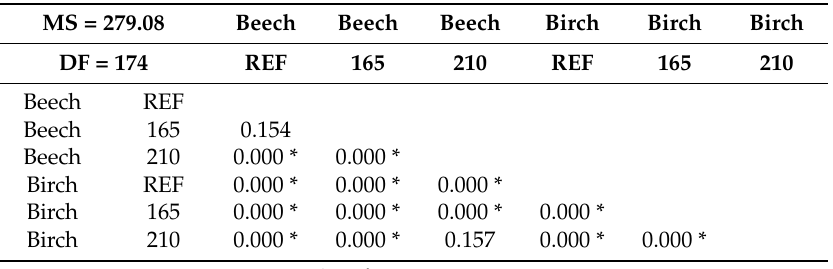
Table A5. Duncan’s Multiple Range Test for Modulus of Rupture.